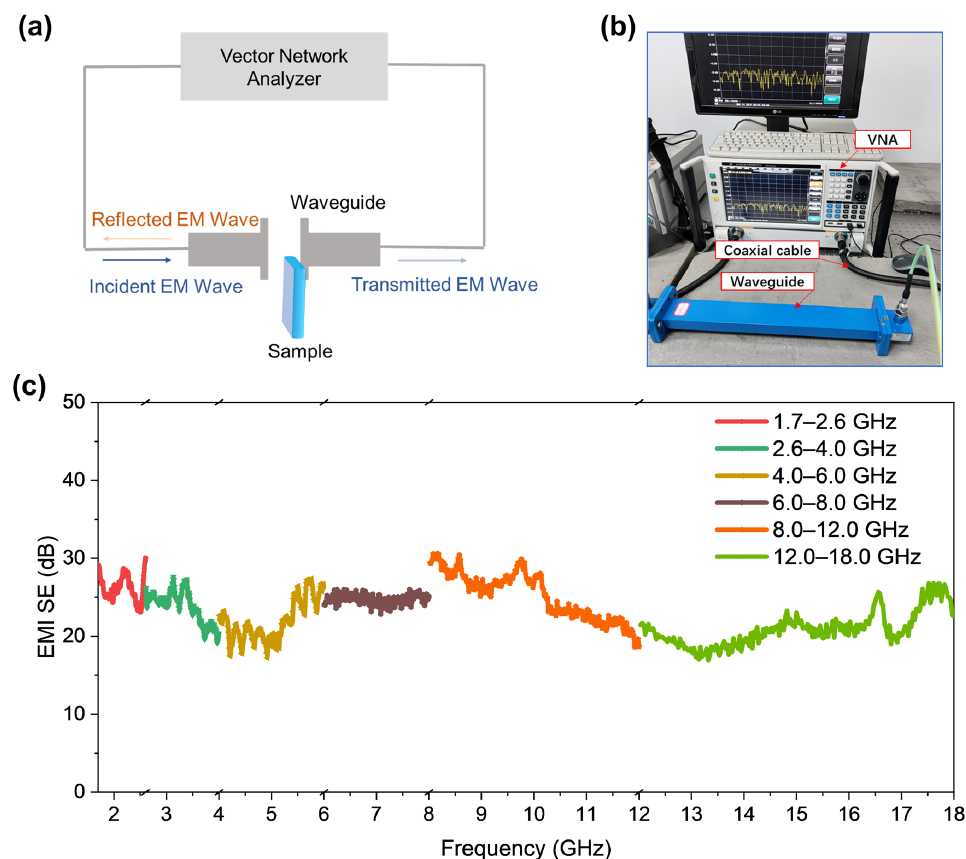
Figure 4. EMI shielding performance. ( a ) Schematic illustration of EMI SE measuring method based on waveguides. ( b ) The actual EMI SE measurement setup. ( c ) Measured EMI SE of transparent electromagnetic shielding window over wide frequency range of 1.7– 18 GHz .